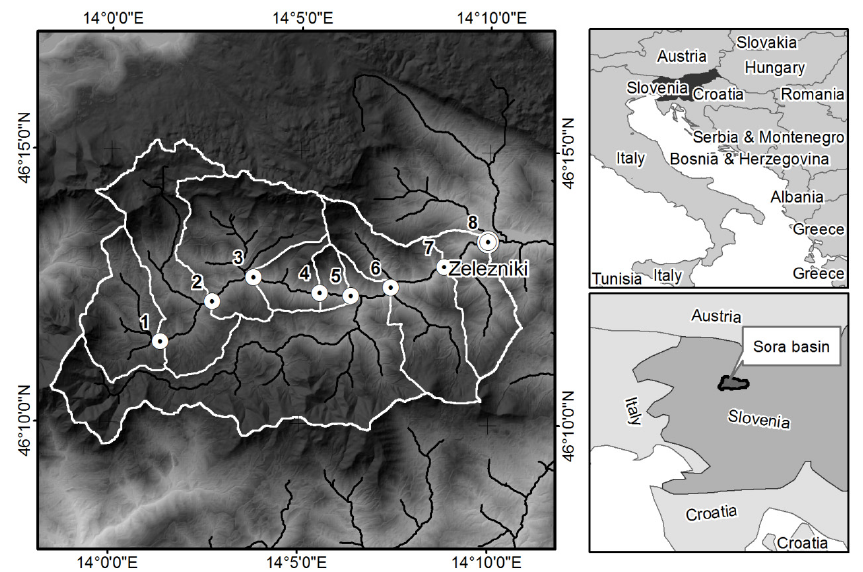
Fig. 9. The seven IPEC locations (1–7) where the peak discharges were estimated from high-water marks and compared to the simulated discharges, and the Zelezniki outlet (8).